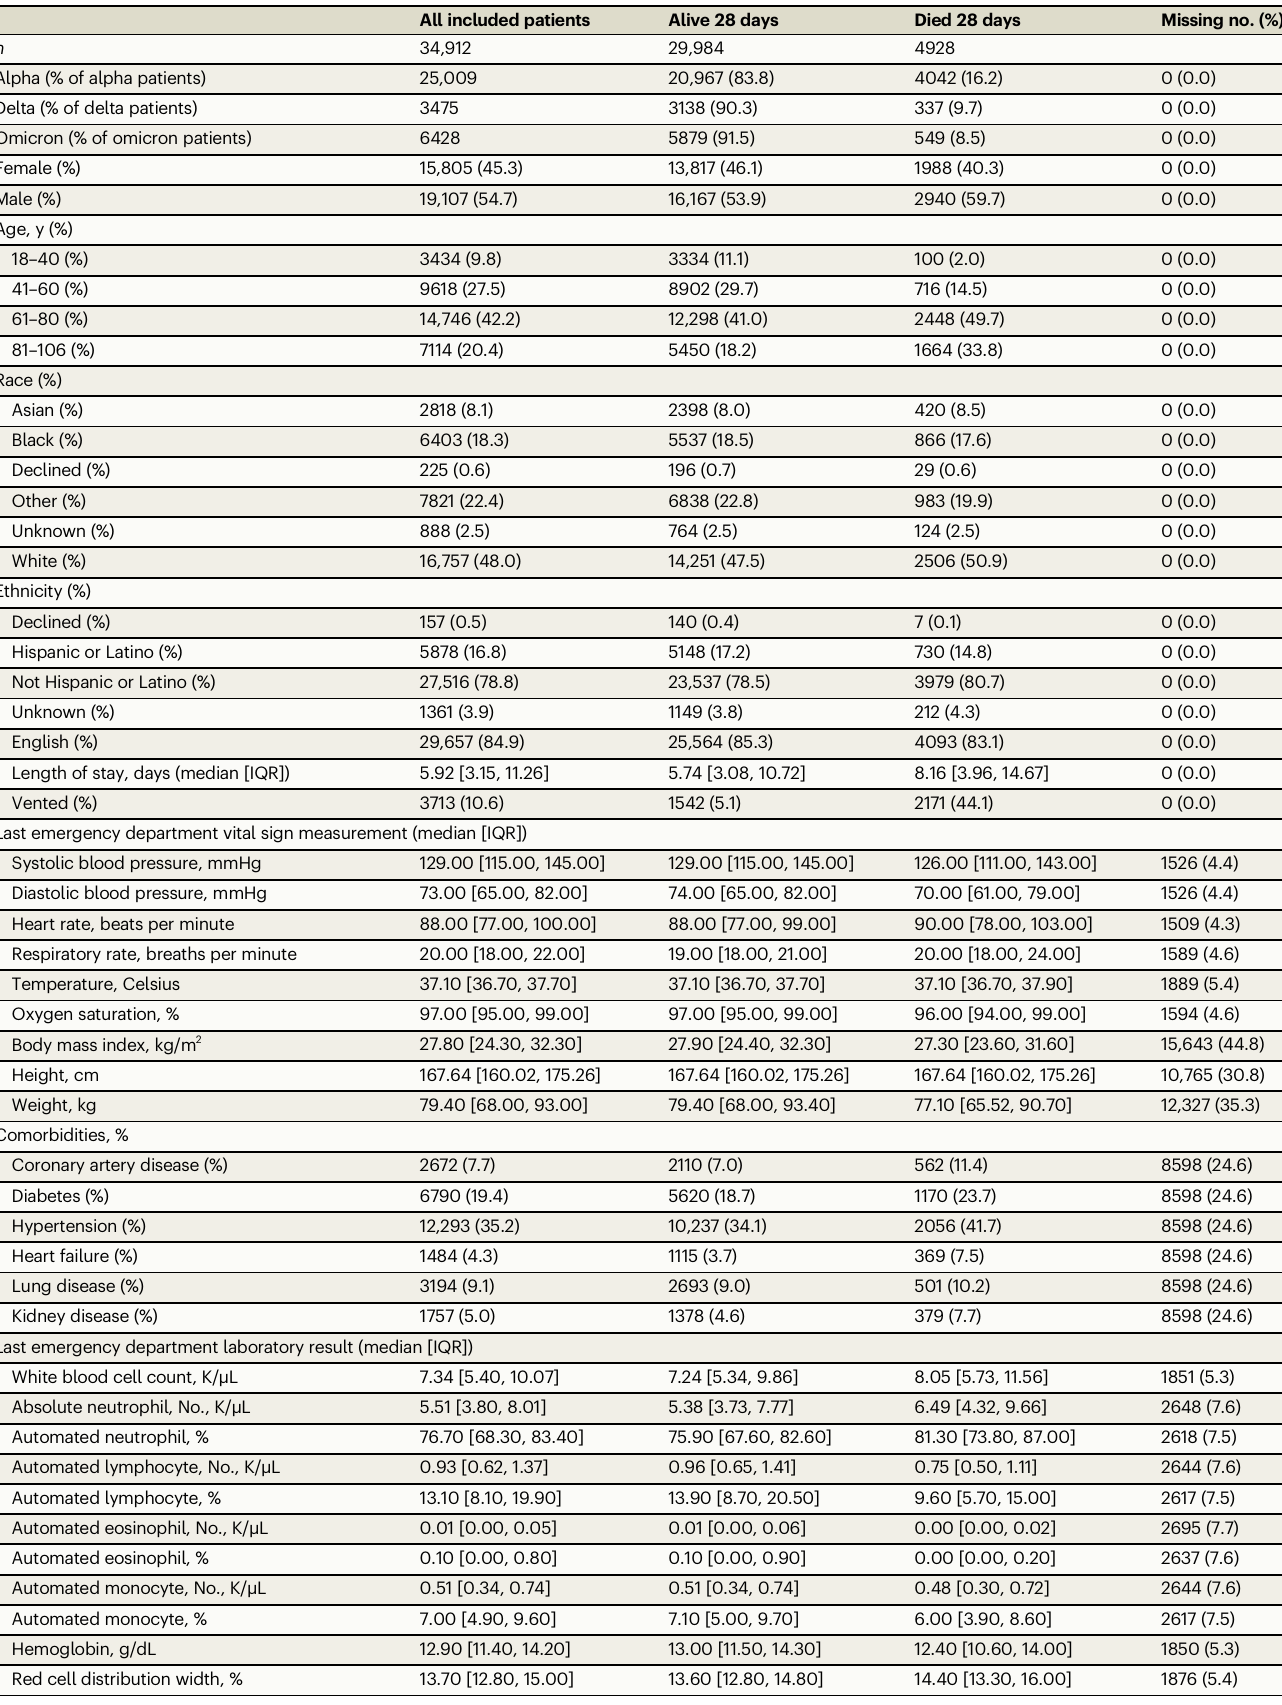
Table 1 | Demographic, clinical, and laboratory data of COVID-19 patients hospitalized at northwell health All included